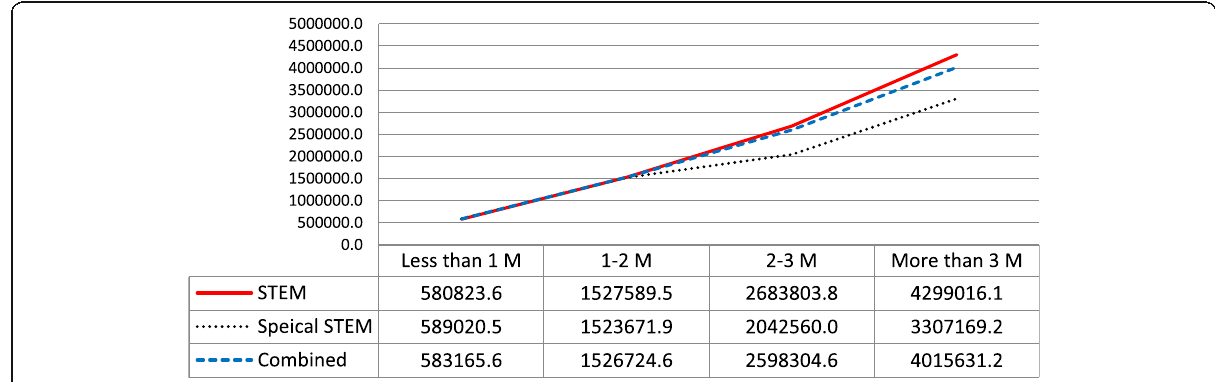
Fig. 6 The average amount of funding per project across different total funding amount and program